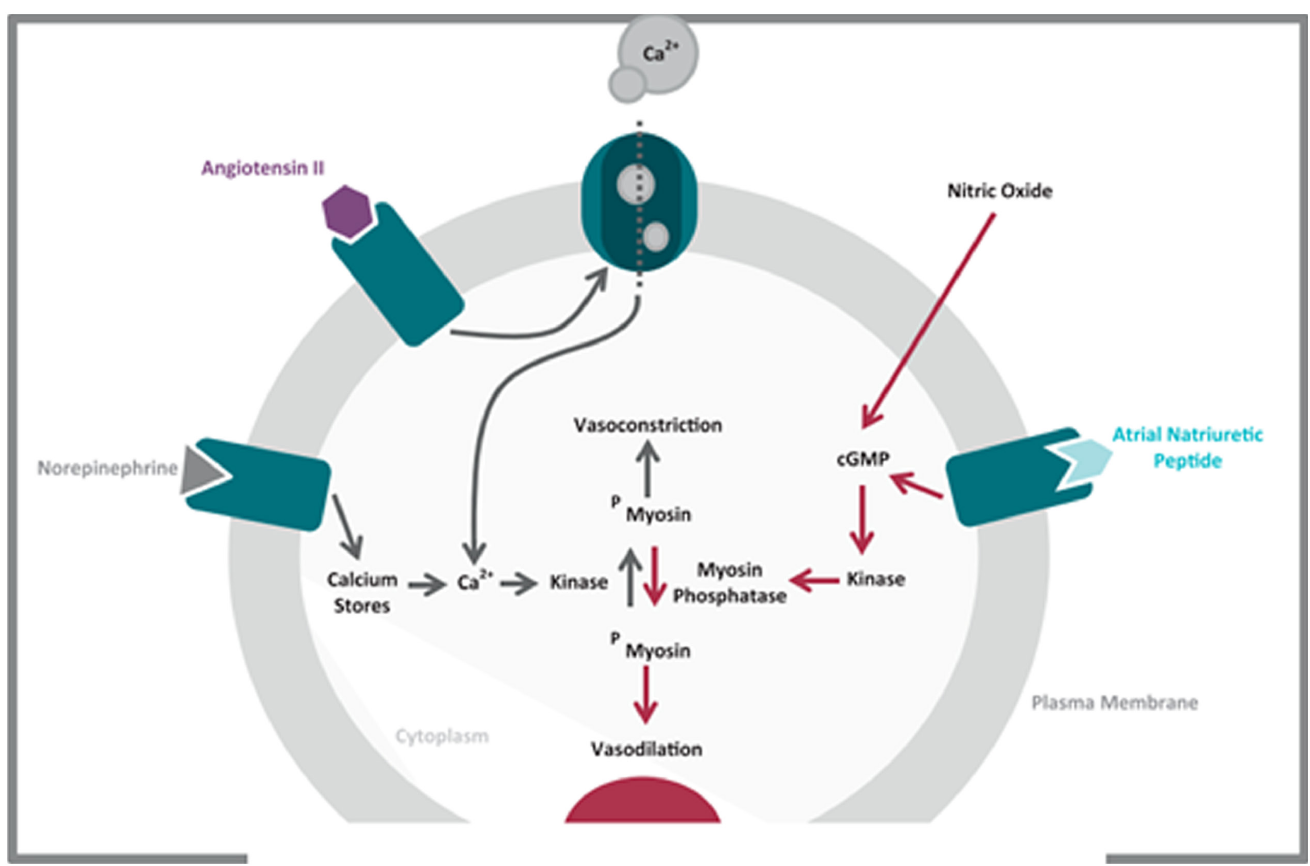
Figure 1. The cellular mechanism of vasodilatory shock. The smooth muscles of blood vessels contract when intracellular calcium levels rise and cause cross bonds between actin and myosin, which are phosphorylated. This process is triggered after vasoconstrictive mediators, such as angiotensin II or catecholamines, bind to surface receptors. Conversely, vasodilation occurs when molecules such as a nitric oxide or atrial natriuretic peptides produce an increase in intracellular cyclic guanosine monophosphate (cGMP) and deposition of myosin.